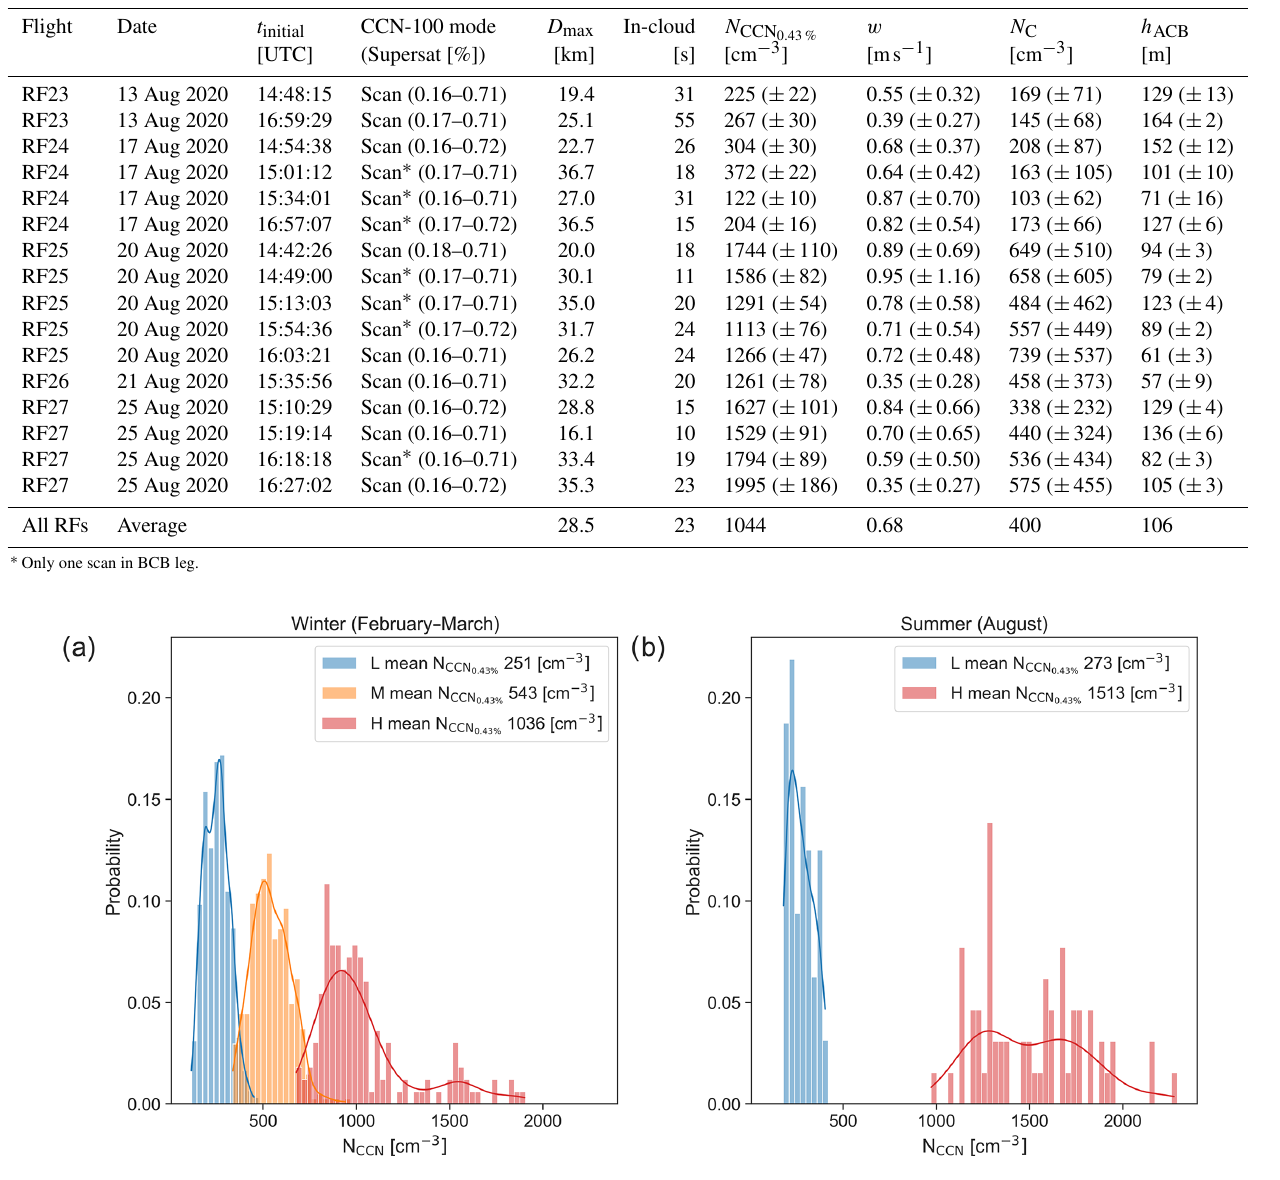
Figure 4. Probability distributions of wintertime low (L/blue), medium (M/orange) and high (H/red) N CCN values (a) . All values are binned with a bin width of 30cm − 3 , and the abscissa gives the probability of occurrence in the group. The line fit represents a kernel density estimation of the Python Seaborn package (Waskom, 2021). The same is done in (b) for the summertime N CCN distribution of the L and H group. No summertime pair is attributable to the M group and is thus not 0 . 43%